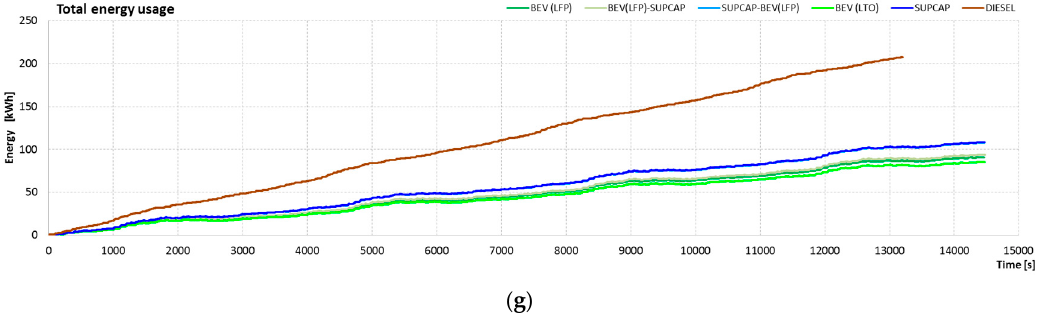
Figure 25. Results of simulation tests of powertrain systems on the Gdynia-Hills route on the section of about 100 km, where: ( a ) Bus speed during tests (km/h); ( b ) Voltage and Current on DC-link (V), (A); ( c ) Motor/Engine Power (kW); ( d ) Battery & SUPCAP State of Charge (%); ( e ) Battery & SUPCAP